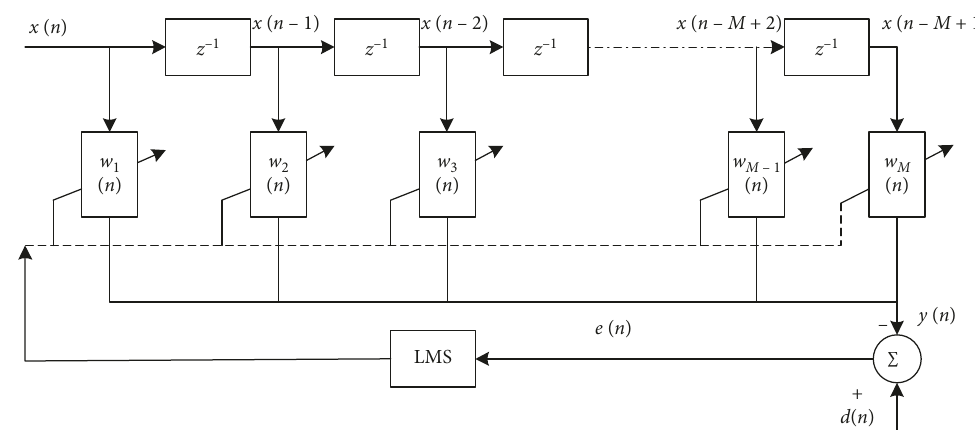
Figure 1: The structure of the LMS adaptive filter.